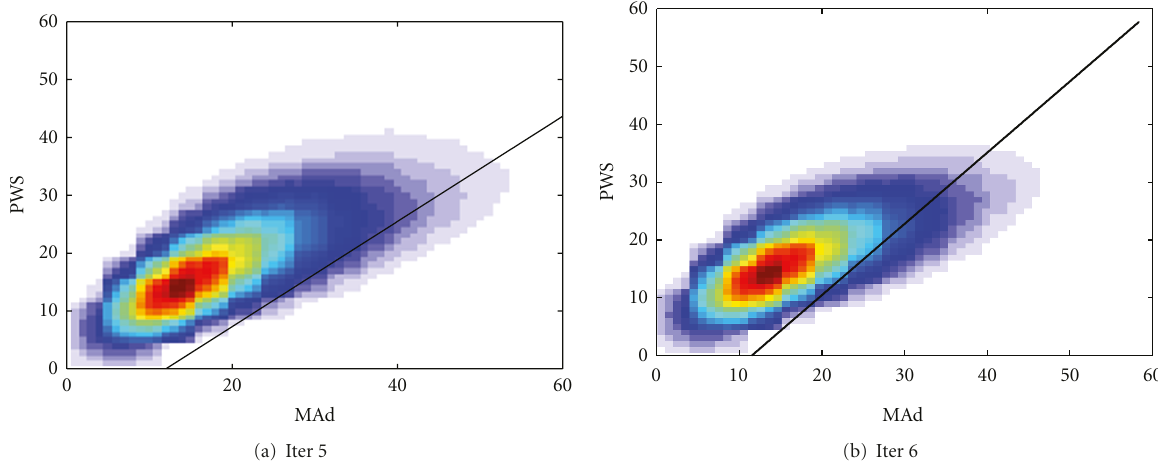
Figure 5: The distribution of noise-free pixels in the 5th and 6th iteration of filtering image Bridge corrupted with 40% mixed impulse noise.